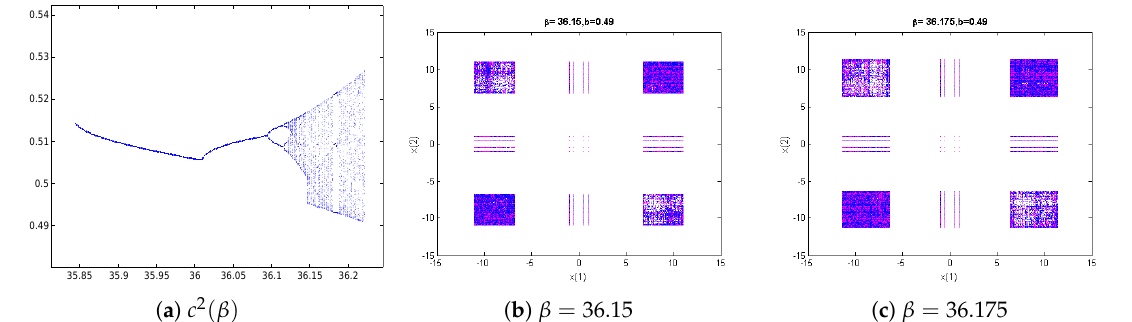
( c ( β ) , β ) , i = 1,2. i j